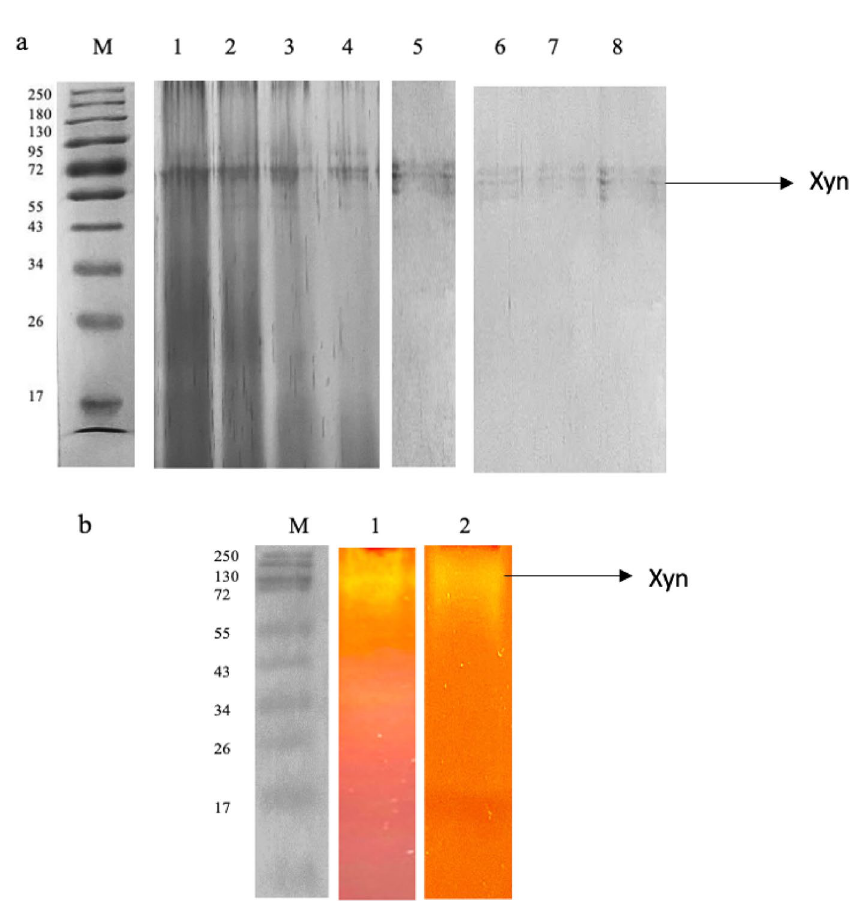
Figure 7. A 12% SDS PAGE ( a ) and Native substrate-PAGE ( b ) analysis of purified xylanase. 12% SDS PAGE (cropped) represents Lane M: Molecular weight marker (Thermoscientific, USA), 1–4: 50, 60, 70, and 80% ammonium sulphate fractions (Coomassie-stained), and 5–8: Purified xylanase from Trichoderma harzianum (Xyn). Native substrate-PAGE (cropped) represents Lane M: Molecular weight marker (Thermoscientific, USA), 1: 50% Ammonium sulphate fraction showing zone of clearance, and Lane 2: Purified xylanase (Xyn) from Trichoderma harzianum on native substrate gel showing zone of clearance. The original gels are presented in Supplementary Figs.